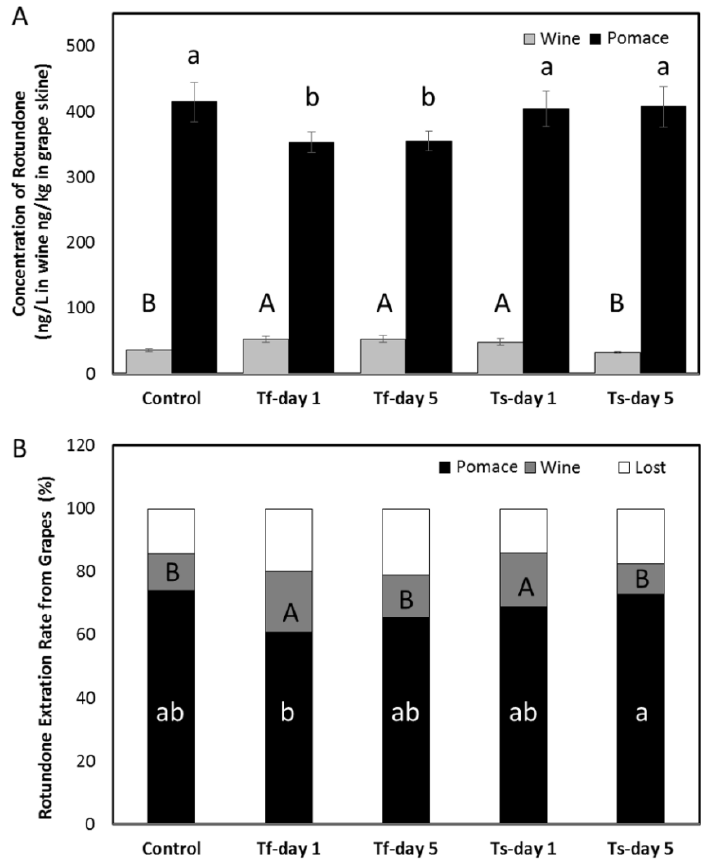
Figure 1. Influences of fortified winemaking techniques on rotundone content in wine. ( A ): The concentration of rotundone in the resultant wine and residual grape pomace was compared with one-way ANOVA analysis ( p < 0.05), significant differences were expressed using a, b. ( B ) The extraction rate of rotundone in the resultant wine and residual rotundone in grape pomace was compared with one-way ANOVA analysis ( p < 0.05), significant differences were expressed using A, B and a, b, respectively.